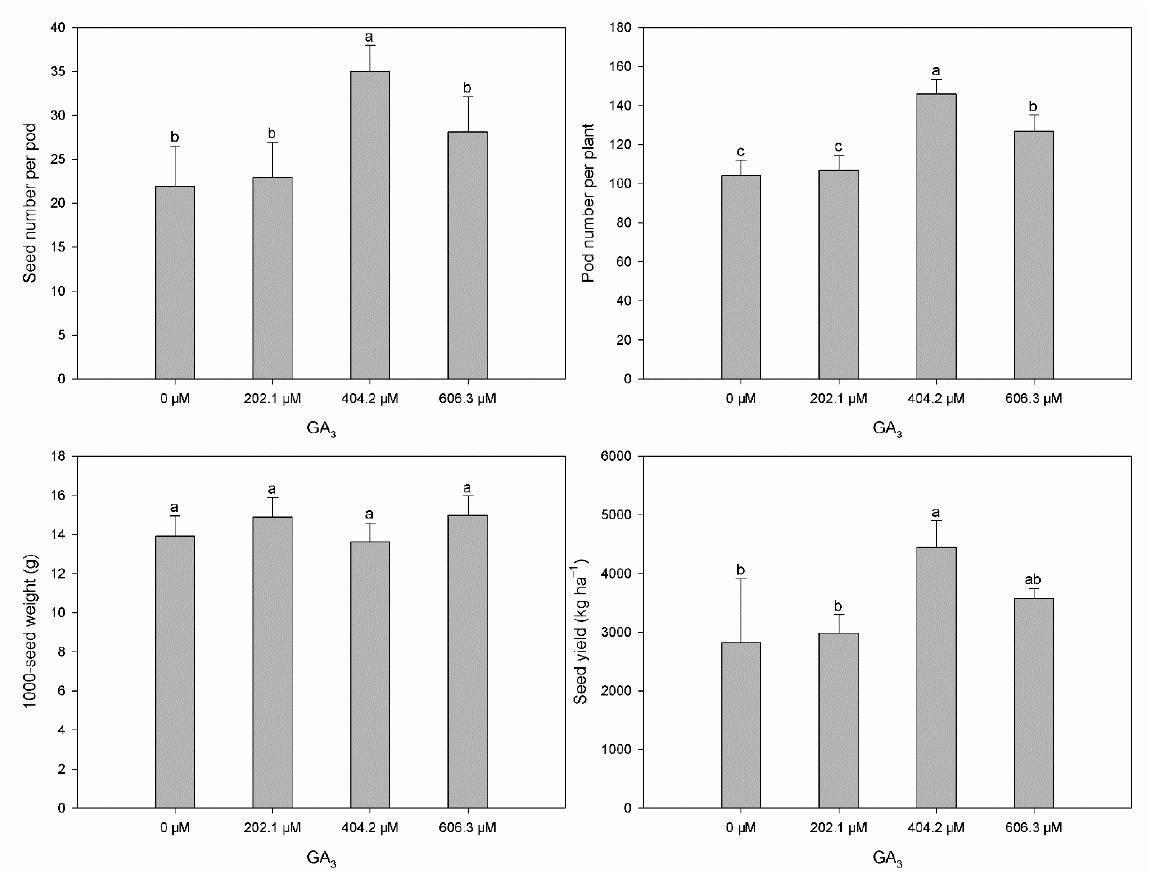
Figure 3. The effects of GA 3 level on the seed yield and yield components of sesbania pea grown in saline soils. Within each group, the data marked with different letters are statistically different at the 0.05 probability level.